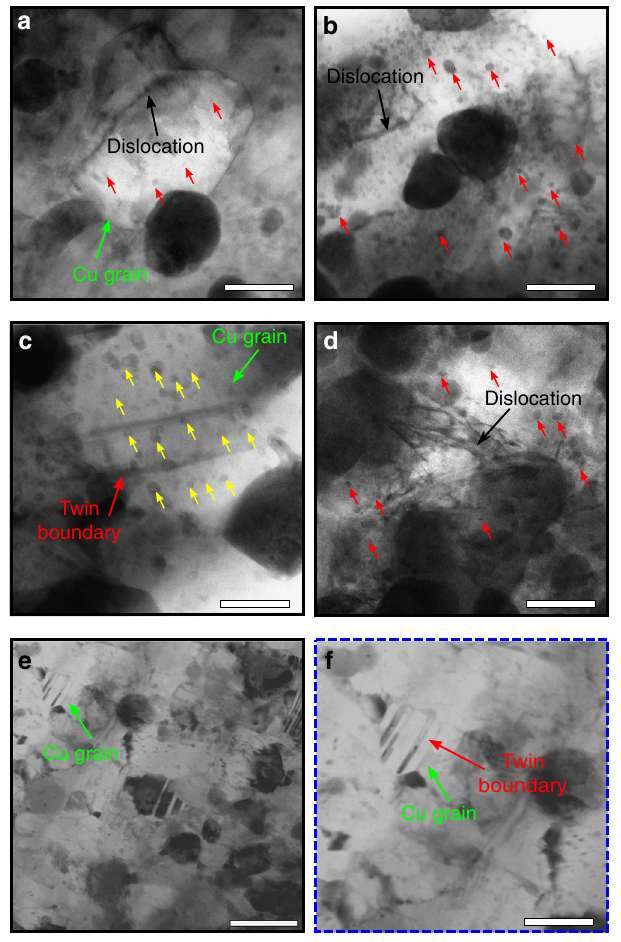
Fig. 3 Microstructural characterization of post-deformed NC-Cu-10 at.% Ta tested at multiple strain rates and temperatures. Post-deformed BF- STEM micrograph of NC-Cu-10 at.% Ta at a 298 K and 10 − 2 s − 1 , b at 873 K and 10 − 2 s − 1 , c at 298 K and 4 × 10 3 s − 1 , d at 873 K and 4 × 10 3 s − 1 , e Taylor anvil tested sample, and f magni fi ed view of the micrograph in e showing twins inside a Cu grain. At lower temperatures (298 K), the high stress contributes toward the nucleation of partial dislocations. At higher temperatures (873 K), emission of dislocations is favored even at 4 × 10 3 s − 1 strain rate. The white bars in a – d and f indicate a length scale of 50 nm and that in e indicates a length scale of 100 nm